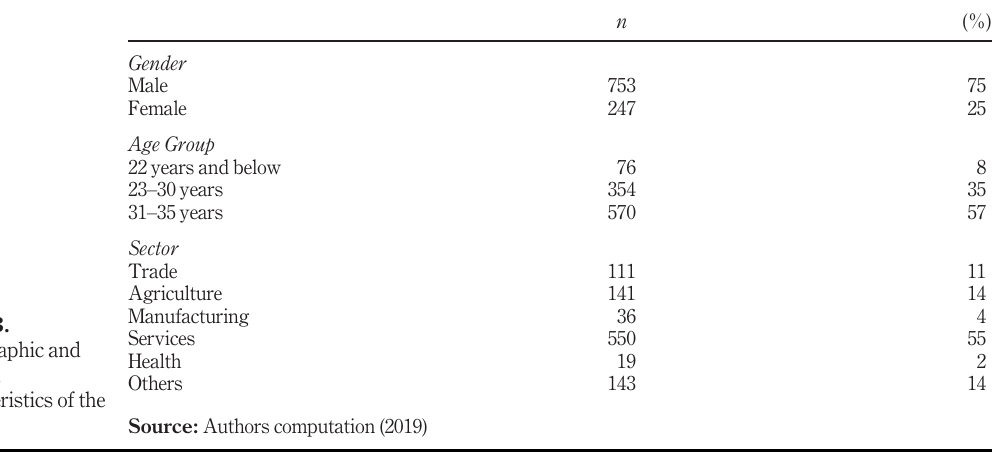
Table 3. Demographic and sectorial characteristics of the